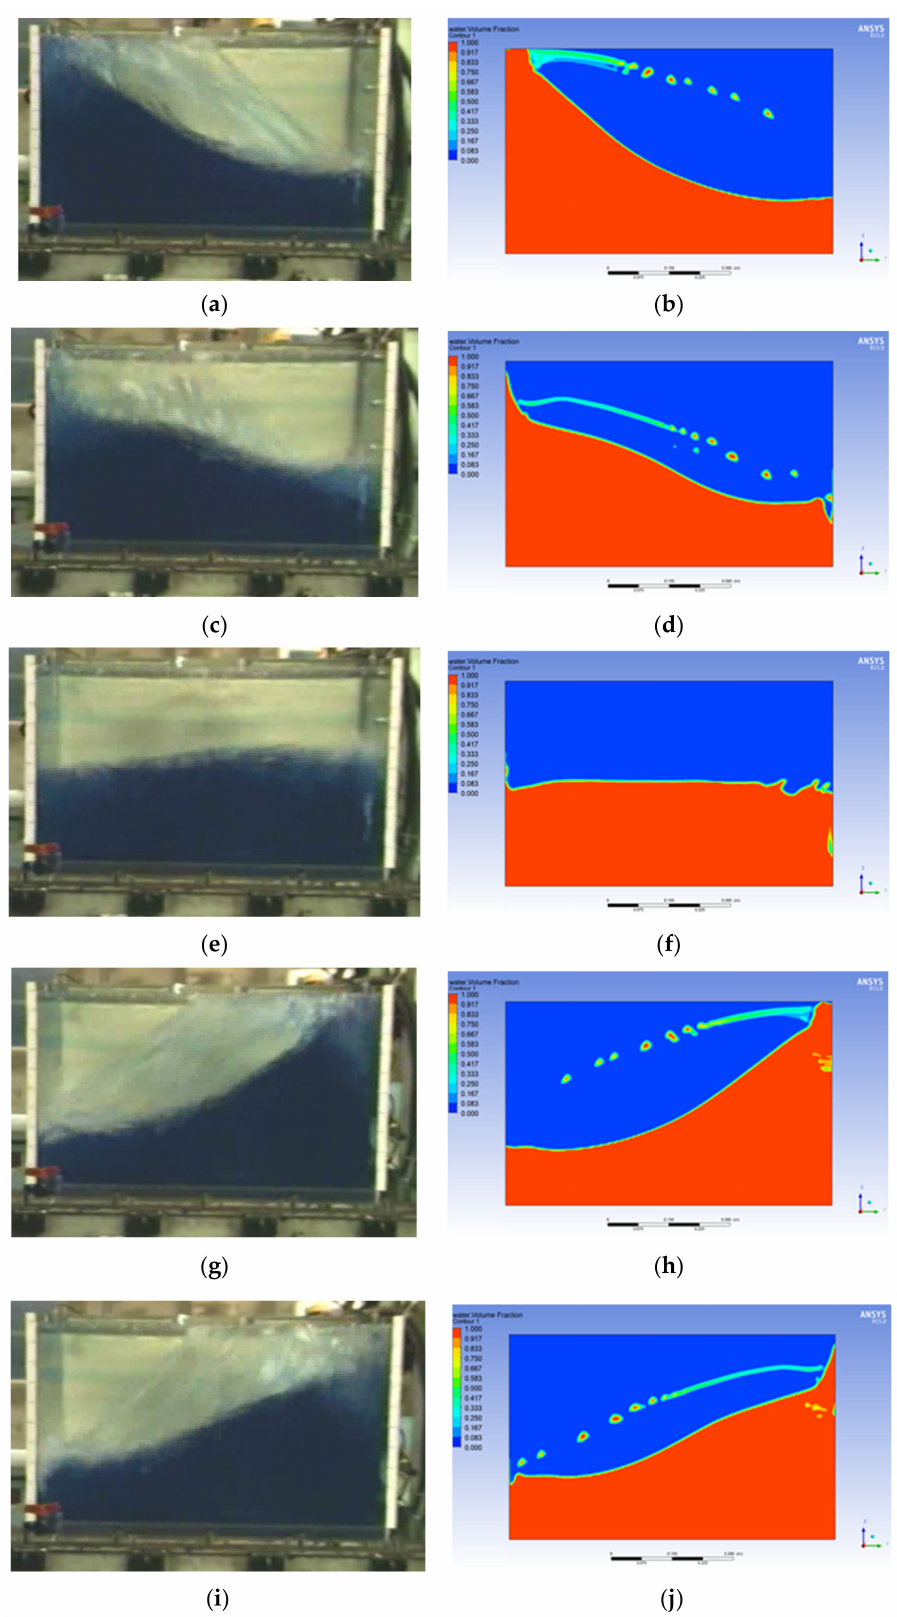
Figure 6. Comparisons of free surface profiles between model test and CFD: ( a ) Experiment; ( b ) CFD; ( c ) Experiment; ( d ) CFD; ( e ) Experiment; ( f ) CFD; ( g ) Experiment; ( h ) CFD; ( i ) Experiment; ( j )